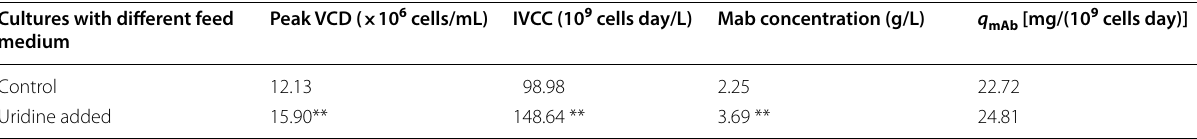
IVCC integral of viable cell concentration with time, q mAb specific mAb production * p < 0.05 relative to control; ** p < 0.01 relative to control